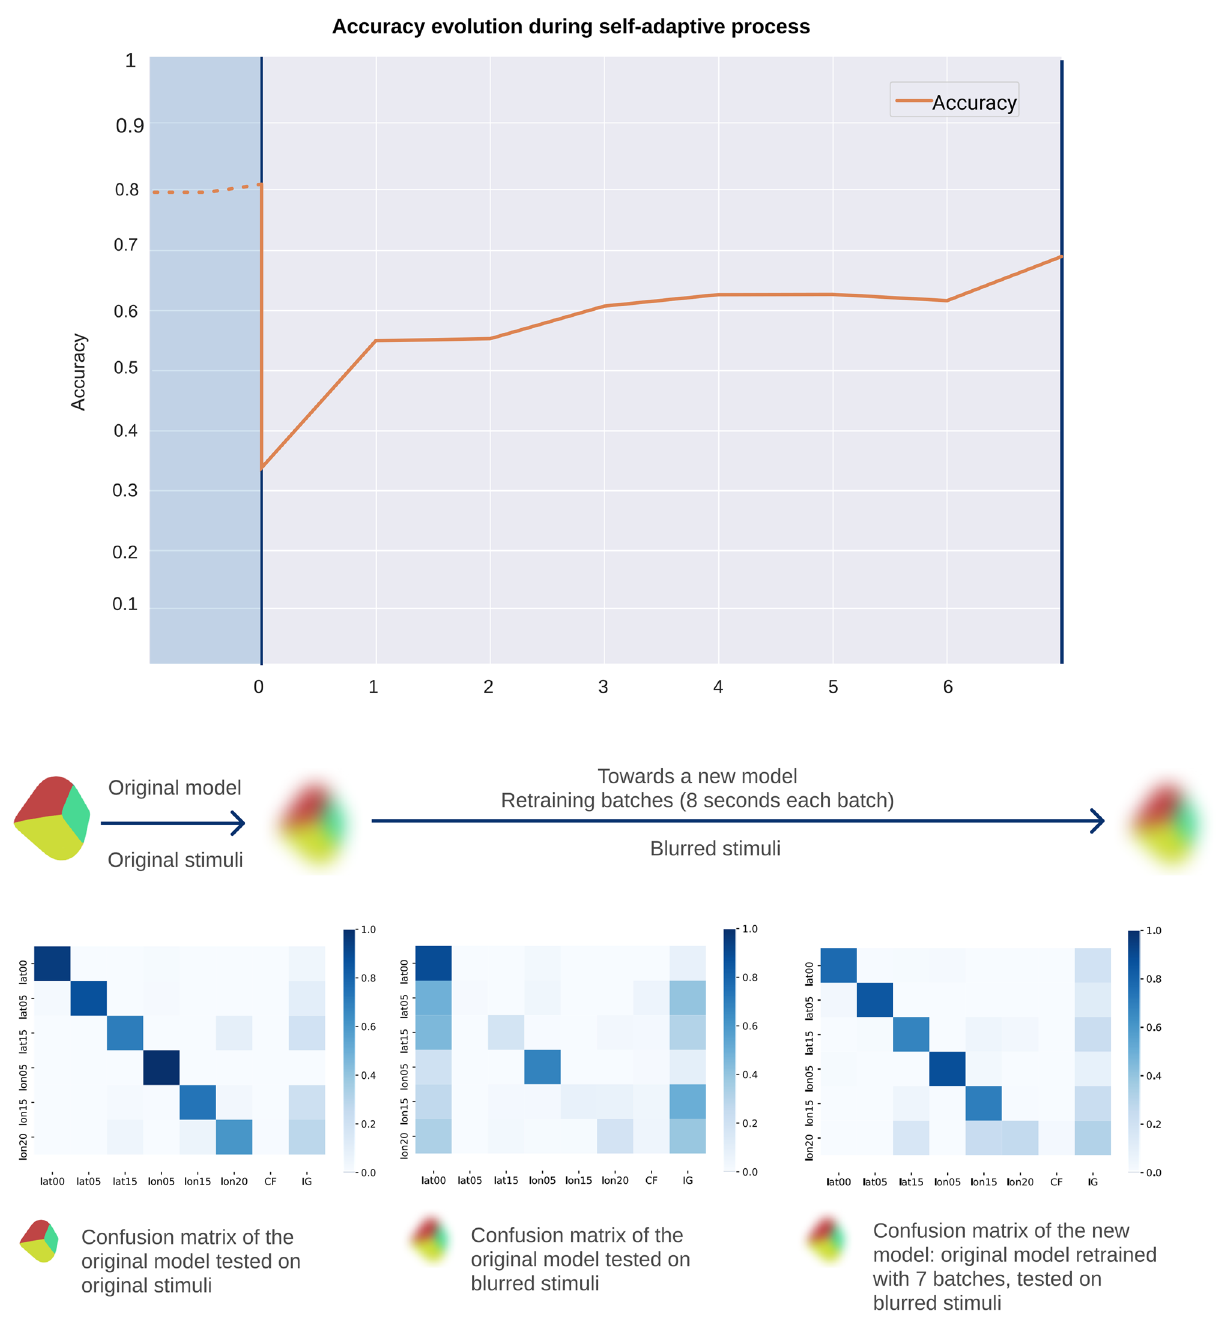
Figure 7. Visual model adaptation to new stimuli acquisition conditions. Top plot shows the decrease in accuracy at the moment (t = 0) when blurred stimuli are first introduced. As blurred batches are incorporated to retrain the system, previous accuracy with original stimuli is now achieved with blurred stimuli (t = 7). Bottom plots show the confusion matrices at the most relevant moments during this adaptation process: (Left) Original model tested with original stimuli, (Center) Original model tested with blurred stimuli (t = 0), (Right) New model after the adaptation process with 7 batches of blurred images (t = 7) tested with blurred